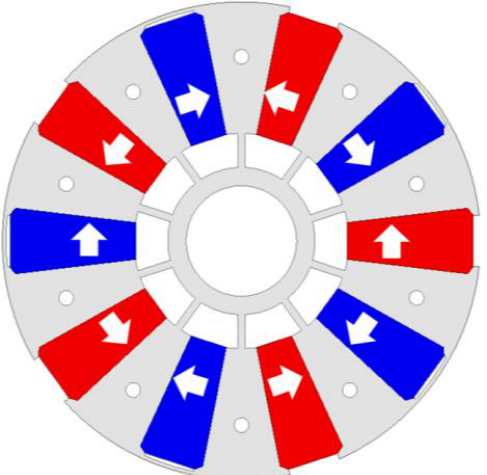
Figure 7. Rotor shape to improve magnetization performance.